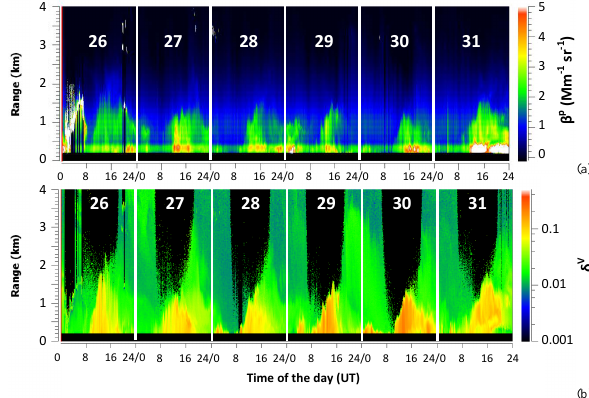
Figure 2. 5-min. resolution time-range plots of the (a) particle backscatter coefficient (β p ) and (b) volume depolarization ratio (δ V ) during 26 – 31 March, 2015. 5 Figure 2. Five-minute resolution time-range plots of the (a) parti- cle backscatter coefficient ( β p ) and (b) volume depolarization ratio ( δ V ) during 26–31 March